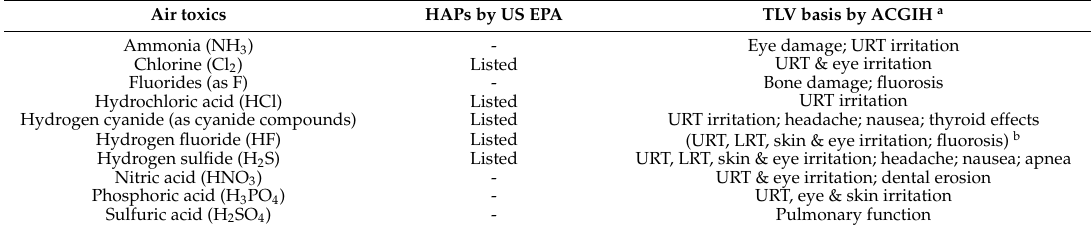
Table 2. The non-carcinogenic human impairments of the air toxics designated in Taiwan using the ACGIH-TLV